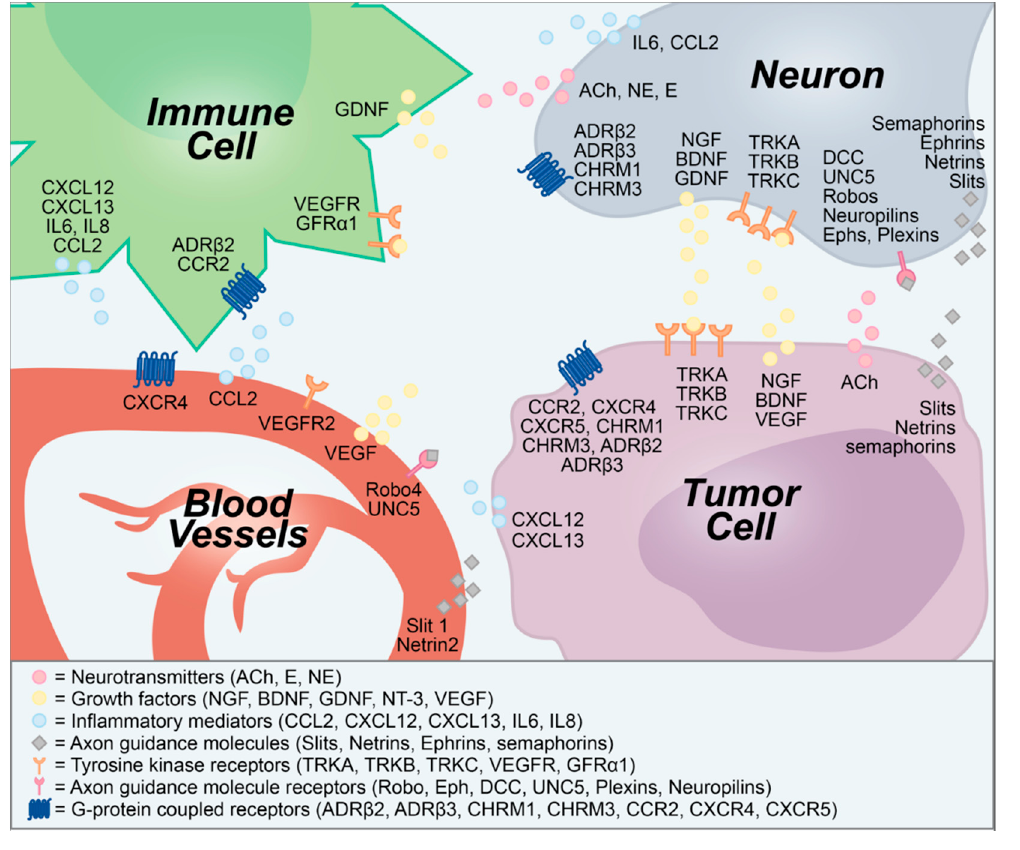
Figure 1. Secreted and membrane-bound molecular signals transmitted between neurons, tumors, blood vessels, and immune cells. ACh, acetylcholine; ADR β , β -adrenergic receptor; BDNF, brain-derived neurotrophic factor; CCL2, chemokine (C-C motif) ligand 2; CCR2, CCL2 receptor; CHRM, cholinergic muscarinic receptor; CXCL, C-X-C chemokine ligand; CXCR, CXCL receptor; DCC, deleted in colorectal cancer; E, epinephrine; Eph, ephrin receptor; GDNF, glial-derived neurotrophic factor; GFR α 1, GDNF family receptor alpha-1; IL, interleukin; NE, norepinephrine; NGF, nerve growth factor; NT-3, neurotrophin-3; TRK, tropomysin-related kinase; UNC5, uncoordinated 5; VEGF, vascular endothelial growth factor.